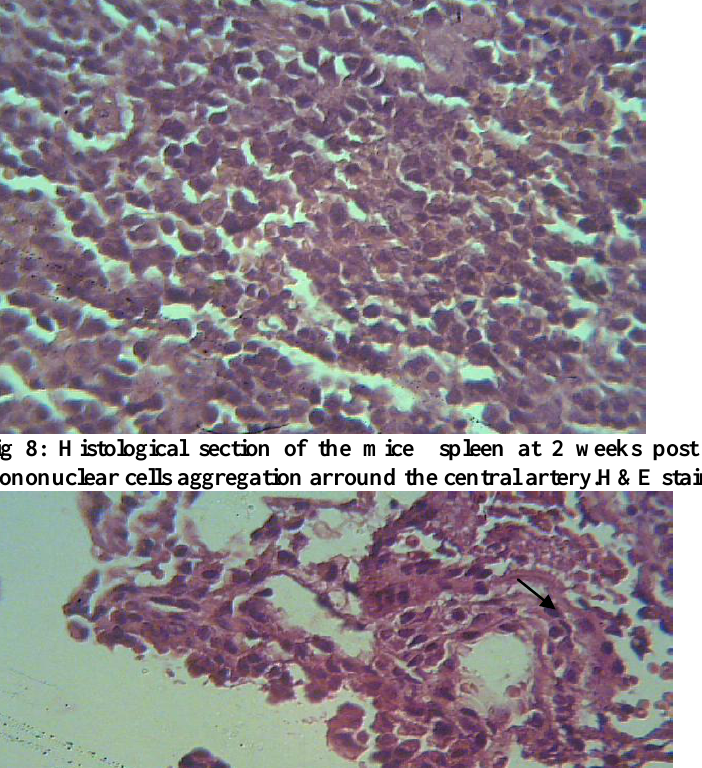
Fig 7 : Histological section of the mice heart at 2 weeks post immunization with HK-CA showed no clear pathological lesions were reported in the heart. H&E stain.